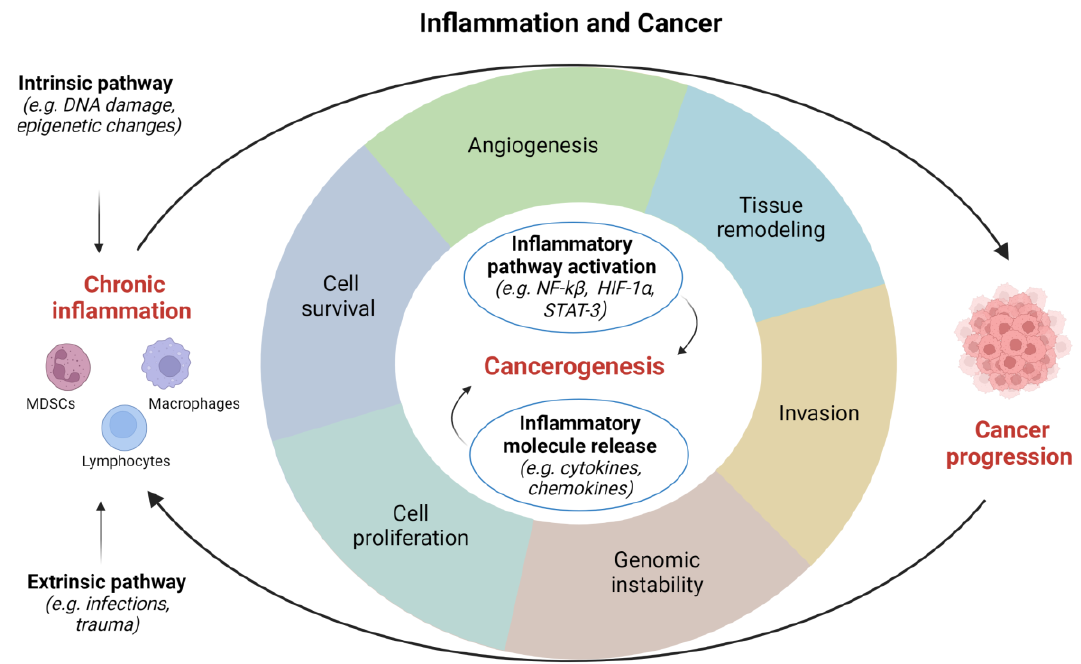
Figure 1. Correlations between inflammation and cancer. HIF , hypoxia inducible factor; NF , nuclear factor; STAT , signal transducer and activator of transcription. Image created with BioRender.com (accessed on 1 December